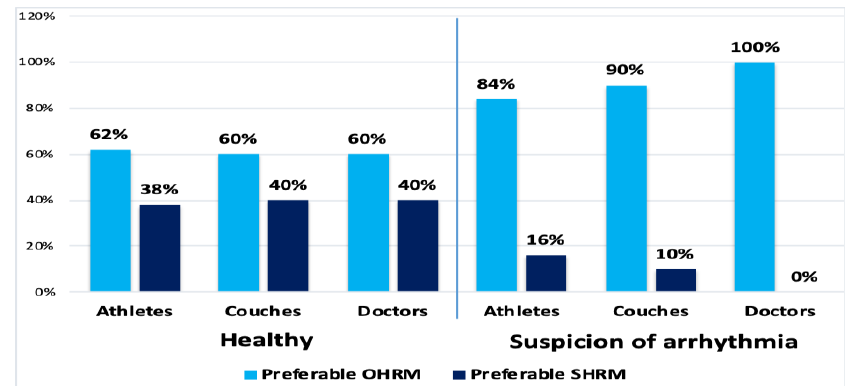
Figure 1. Preferences for the use of HRMs (optical/strap) by athletes, coaches, and doctors in a typical situation and under the hypothetical assumption of suspicion of an arrhythmia in an athlete. Equal and full resistance to artifacts was assumed. Comparison of results of healthy individuals with those of participants with suspected arrhythmia. OHRM, optical heart rate monitor; SHRM, strap heart rate monitor, p < 0.001 in every compared pair.